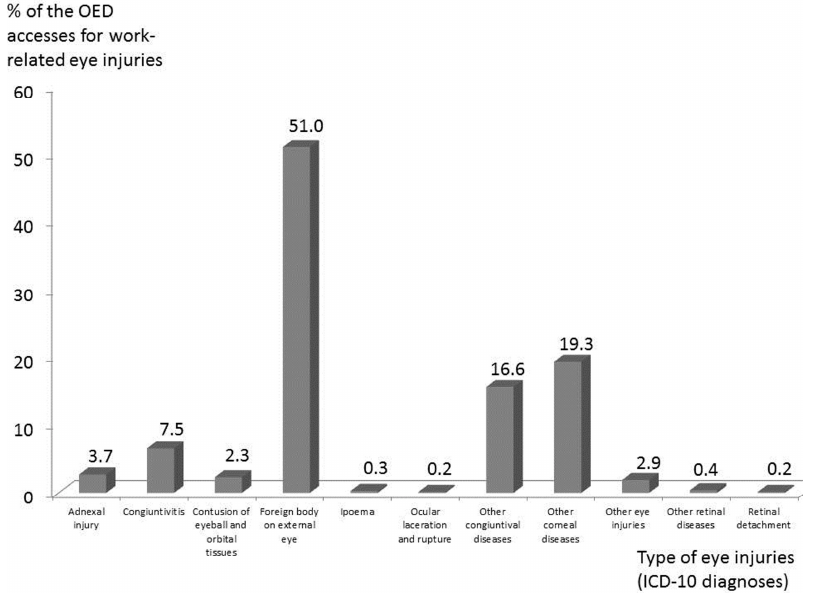
Figure 6. Types of eye injuries classified according to the 10th revision of the International Statistical Classification of Diseases and Related Health Problems (ICD-10) on the total of the 2014 accesses at the Ophthalmological Emergency Department (OED) of the province of Modena for work-related eye